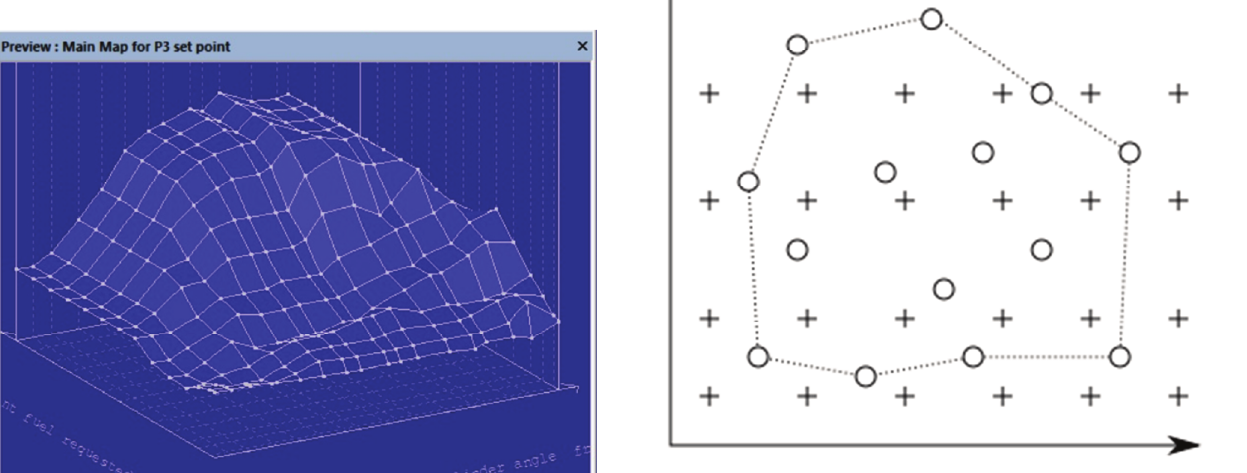
Fig. 3. The distribution of measuring points (circles) in relation to the points contained in the array (+) The problem of interpolation can be easily solved by creating triangles based on measuring points. This makes it possible to easily determine the interpolated value inside the triangle. Unfortunately, there are many ways to create triangles based on the same set of points. Changing the triangle arrangement results in different interpolation re- sults. In some cases, it is not possible to determine which result is correct and the differences can be very large. Fig- ure 4 shows two ways of combining triangles giving differ- ent interpolated values a and b.